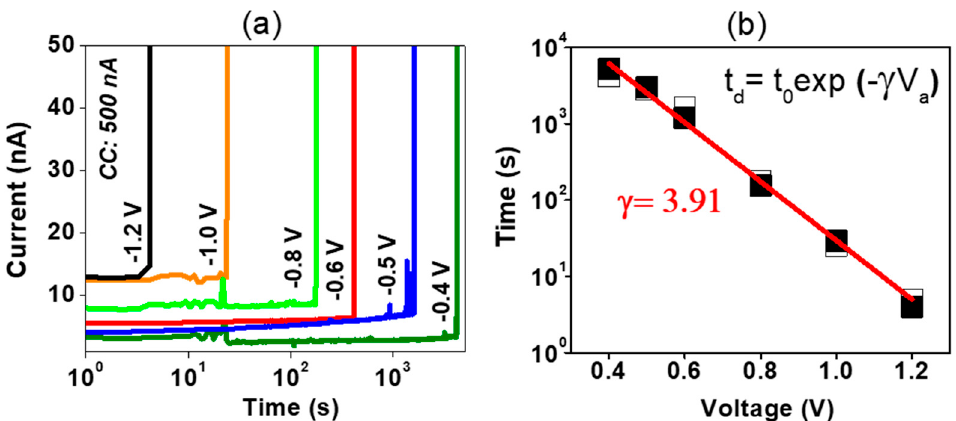
Figure 3. Current with respect to time under different constant voltage bias ( a ). Delay time to pre-forming with respect to voltage ( b ). Two individual measurements are shown by the filled and empty symbols. The exponential fit is shown in red.